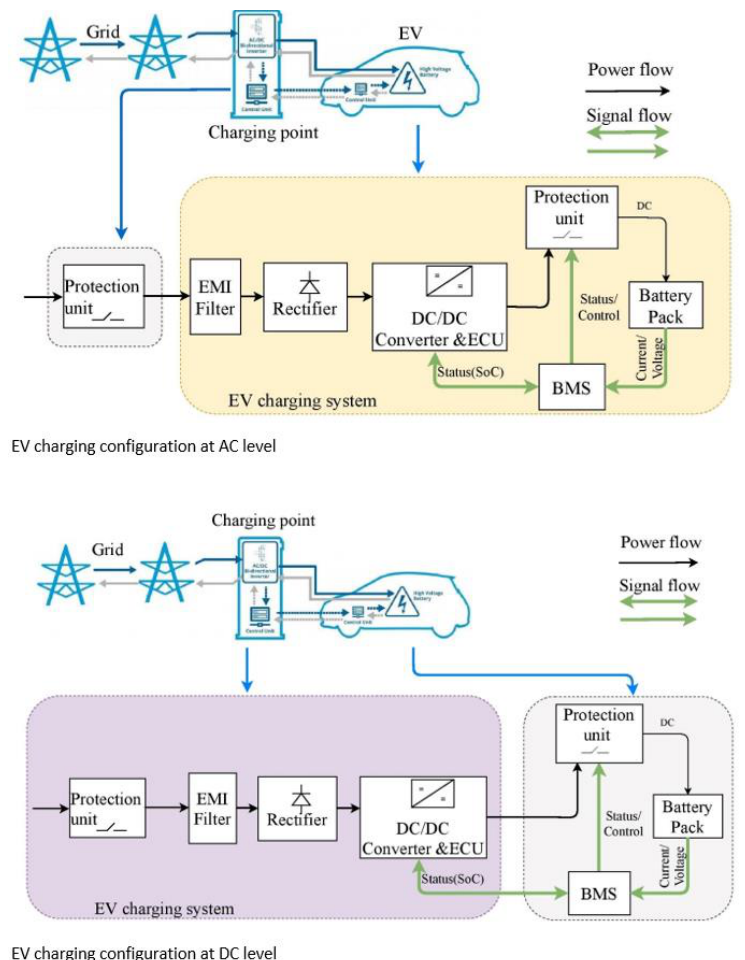
Figure 12. Control of electric vehicle charging system both in alternating current and direct current configurations (Note: EV—electric vehicle, EMI—electromagnetic interference filter, DC—direct current, ECU—electronic control unit, SoC—state of charge, BMS—battery management system, AC—alternating current).